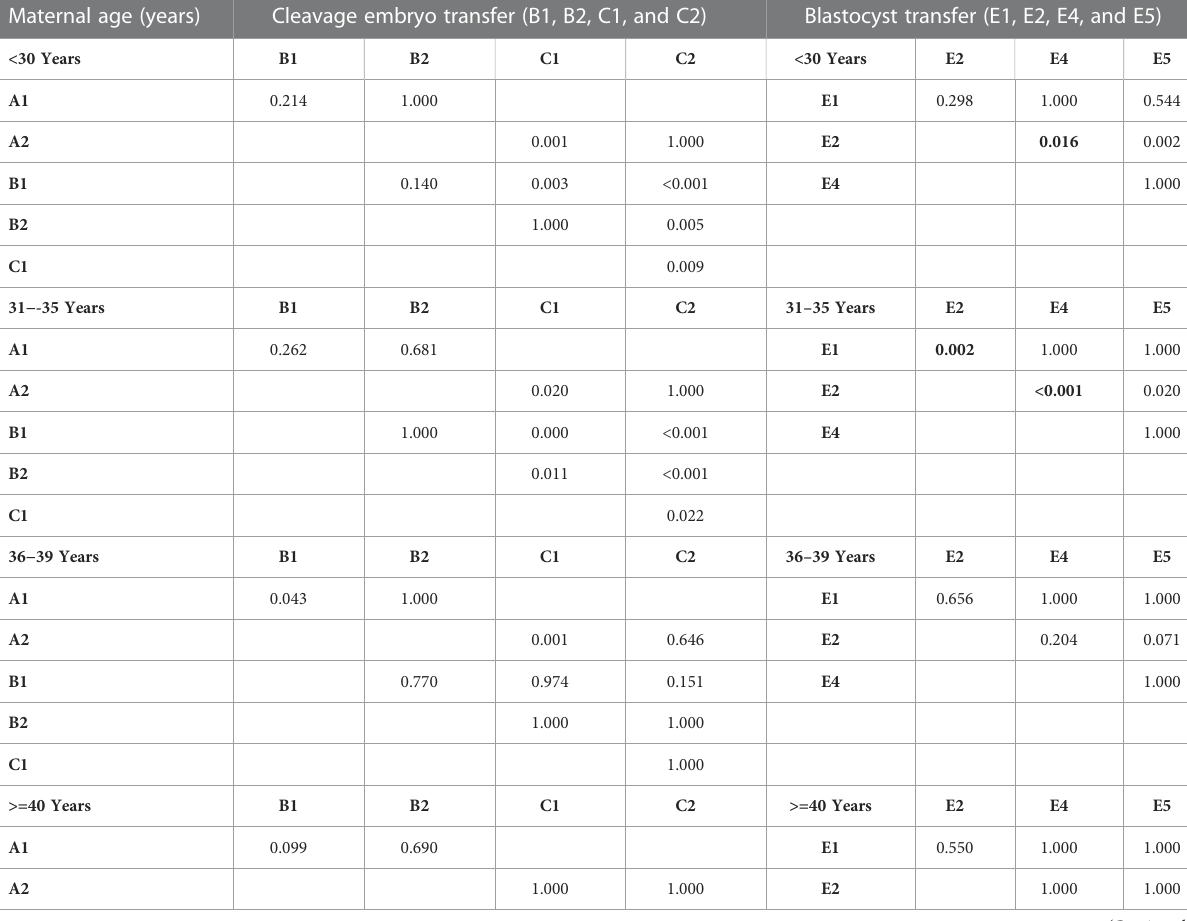
TABLE 7 Multiple comparisons of live birth rate in embryo transfer groups with p-value adjustments by Bonferroni correction. Maternal age (years) Cleavage embryo transfer (B1, B2, C1, and